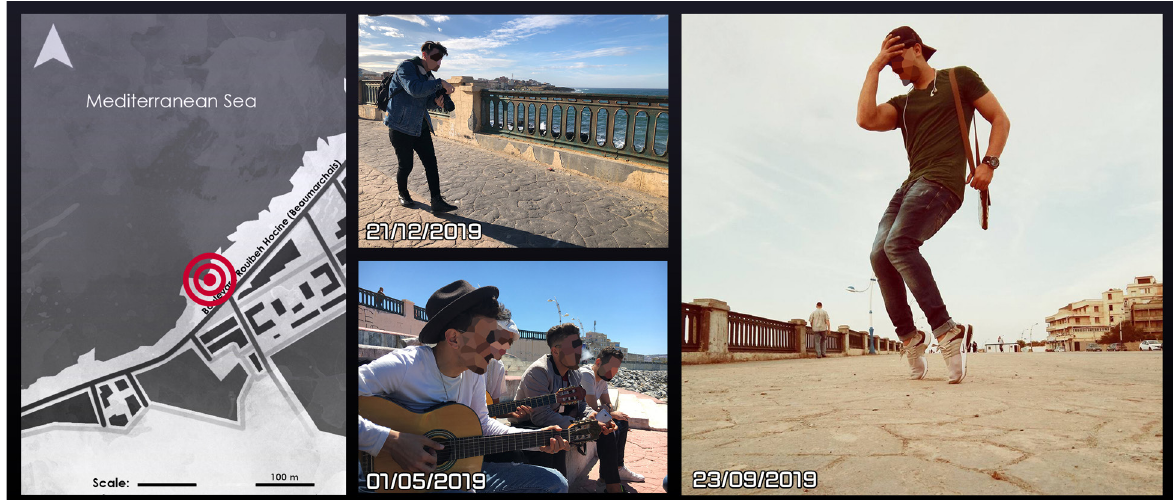
Fig. 4. 2.0. Youth between visual and signage – Roubeh Hocine boulevard. Source: Khelfallah